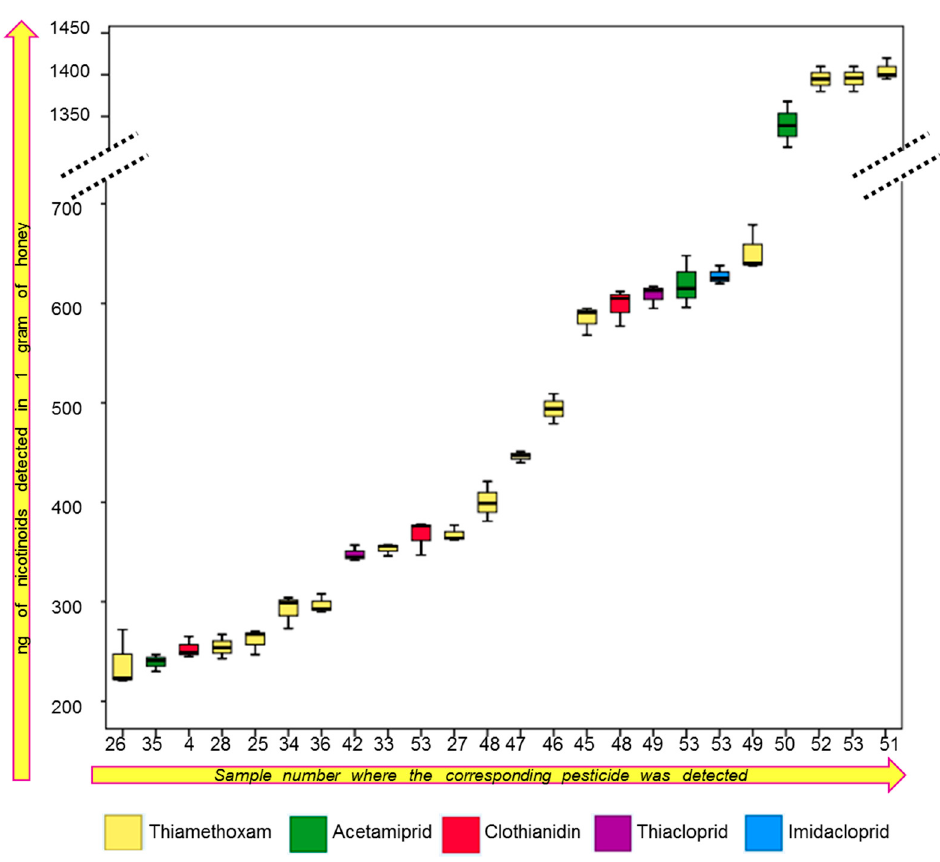
Figure 5. Whiskers box plots presenting the concentration of quantified pesticides which exceeded the LOQ in the investigated samples. The samples number is allotted similar to those presented in Figure